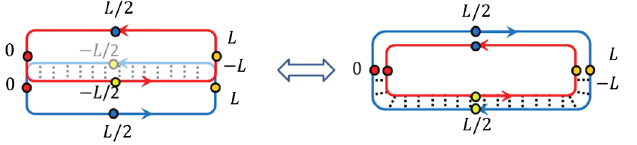
FIG. 4. Edge theory picture of TLJ in Fig. 2(b). The coordinate ~ x increases from − L to þ L following the direction indicated by orange, yellow, red, and blue dots. The second layer (blue) is flipped in the image on the right.